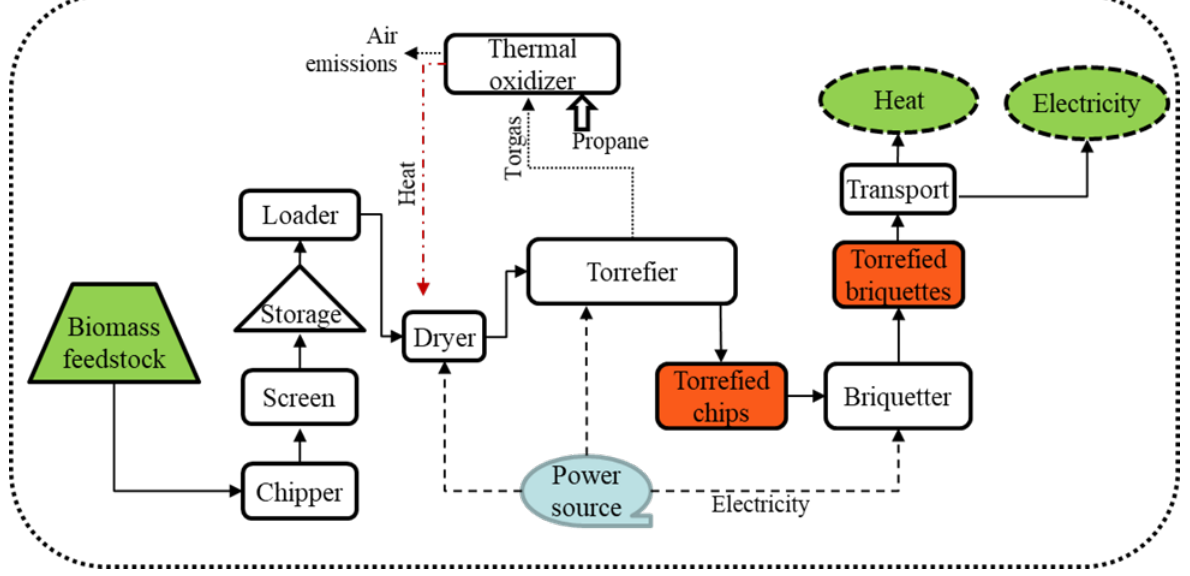
Figure 3. Forest landing to product 2—Process flow diagram of torrefied wood briquette (TWBs): manufacturing of TWBs at the near-woods site and delivery to the customers in the city for heat and electricity